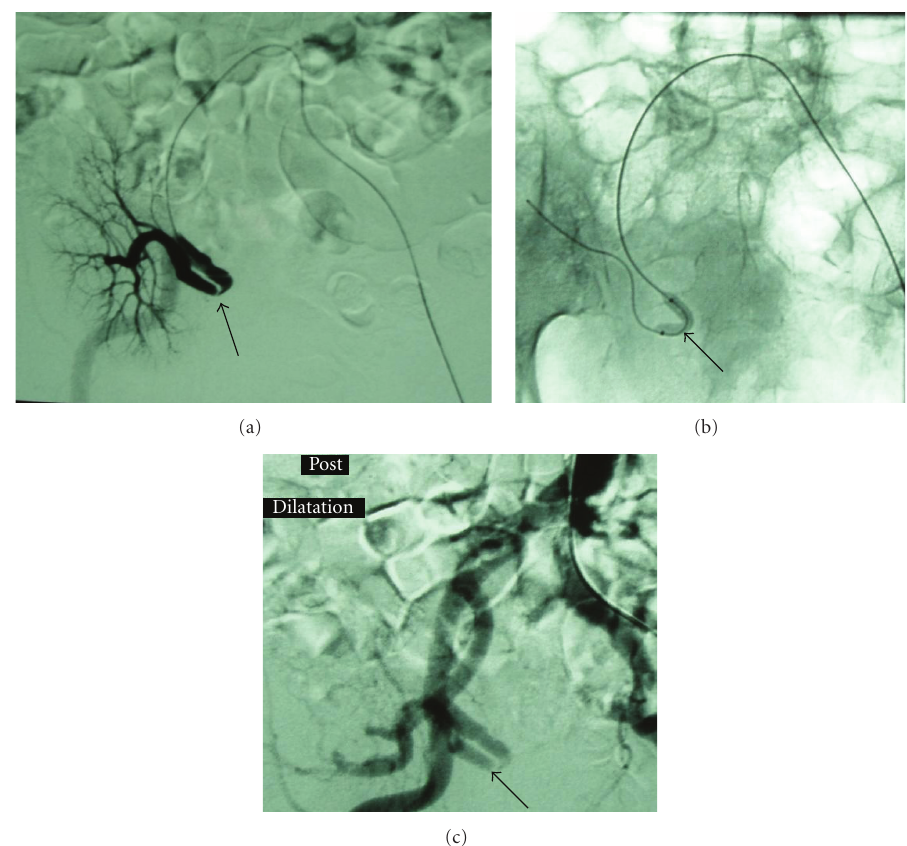
Figure 6: (a) Contralateral selective catheterization of the transplant renal artery shows the kinking and stenosis (arrow). This patient underwent the renal transplantation before 15 days. (b) Balloon angioplasty of the renal artery (arrow). Stent placement was not successful on this particular patient. (c) Angiography after balloon dilatation. The artery does not appear any improvement